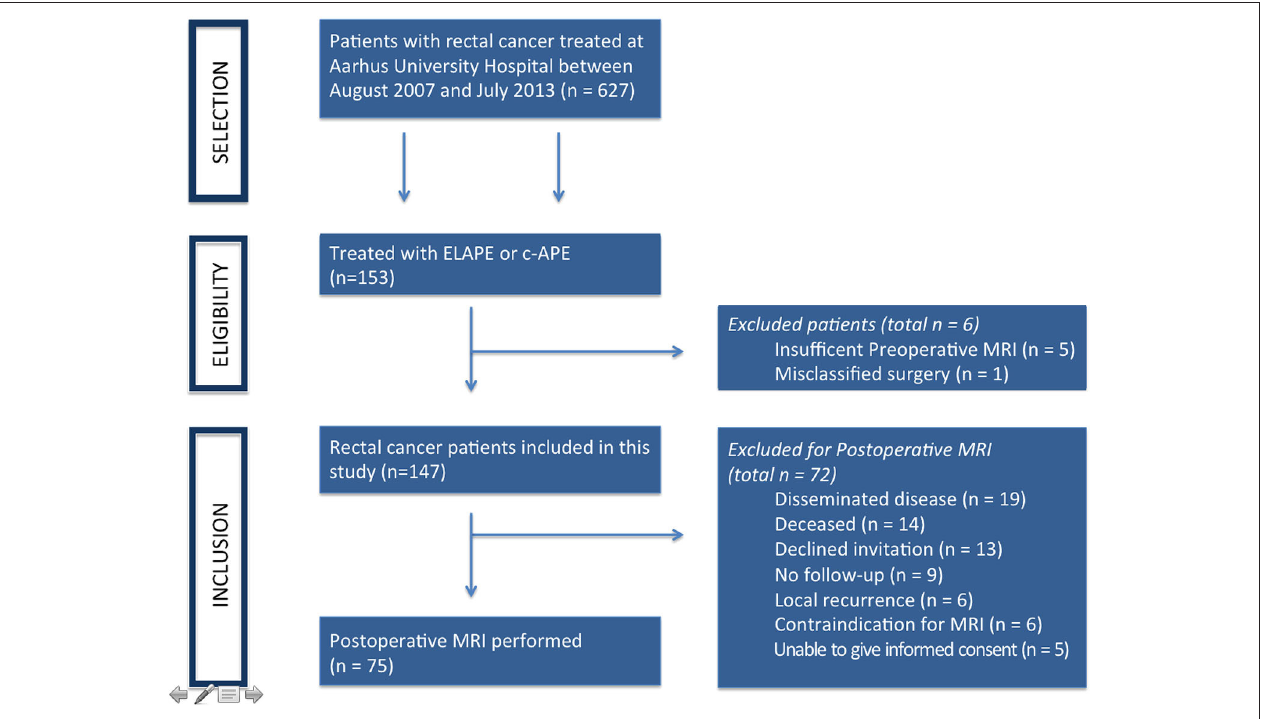
FIGURE 1 | Patient inclusion